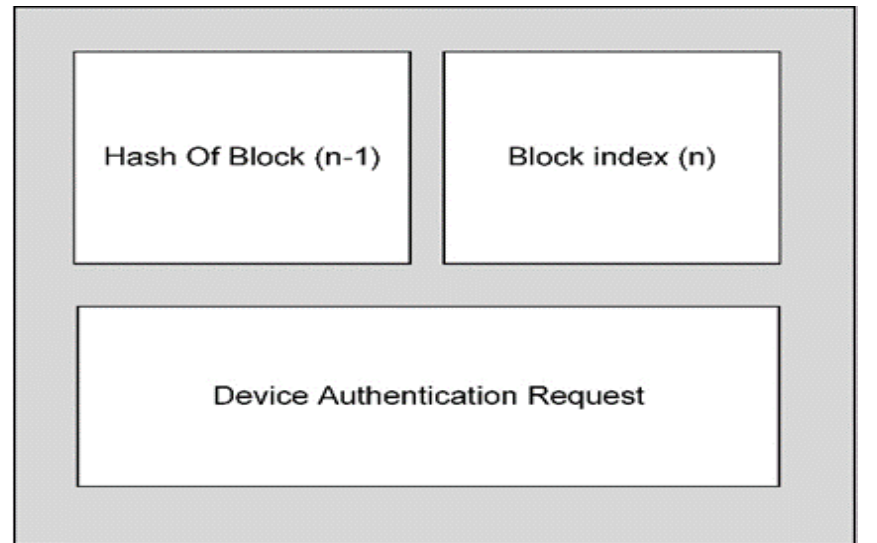
Figure 3. Authentication chain block structure.